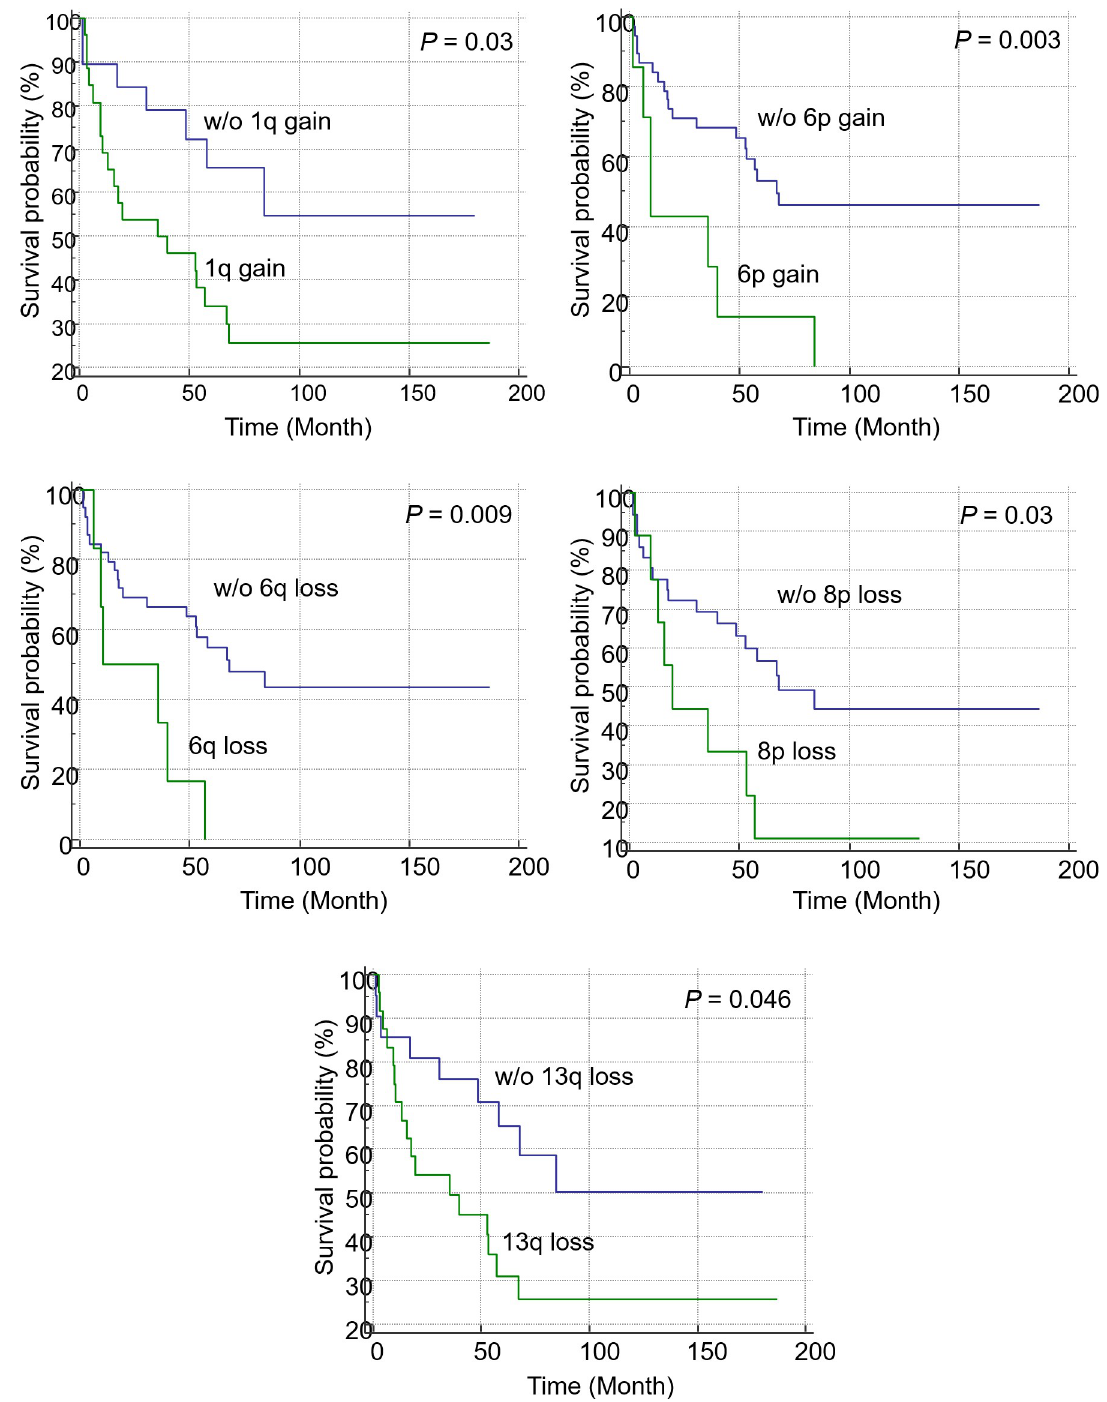
Fig 4. Kaplan-Meier analysis of overall survival in patients with copy number variations. Patients with 1q gain ( P = 0.03), 6p gain ( P = 0.003), 6q loss ( P = 0.009), 8p loss ( P = 0.03), and 13q loss ( P = 0.046) were significantly correlated with poor prognosis in the log- rank